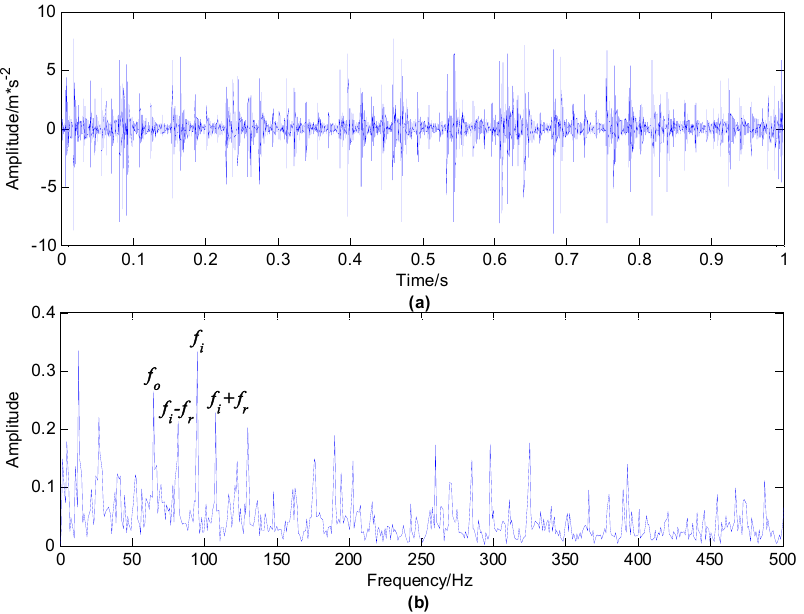
Figure 11. Rolling bearing signal with outer race, inner race and rolling element compound fault: ( a ) time waveform; ( b ) envelope spectrum.